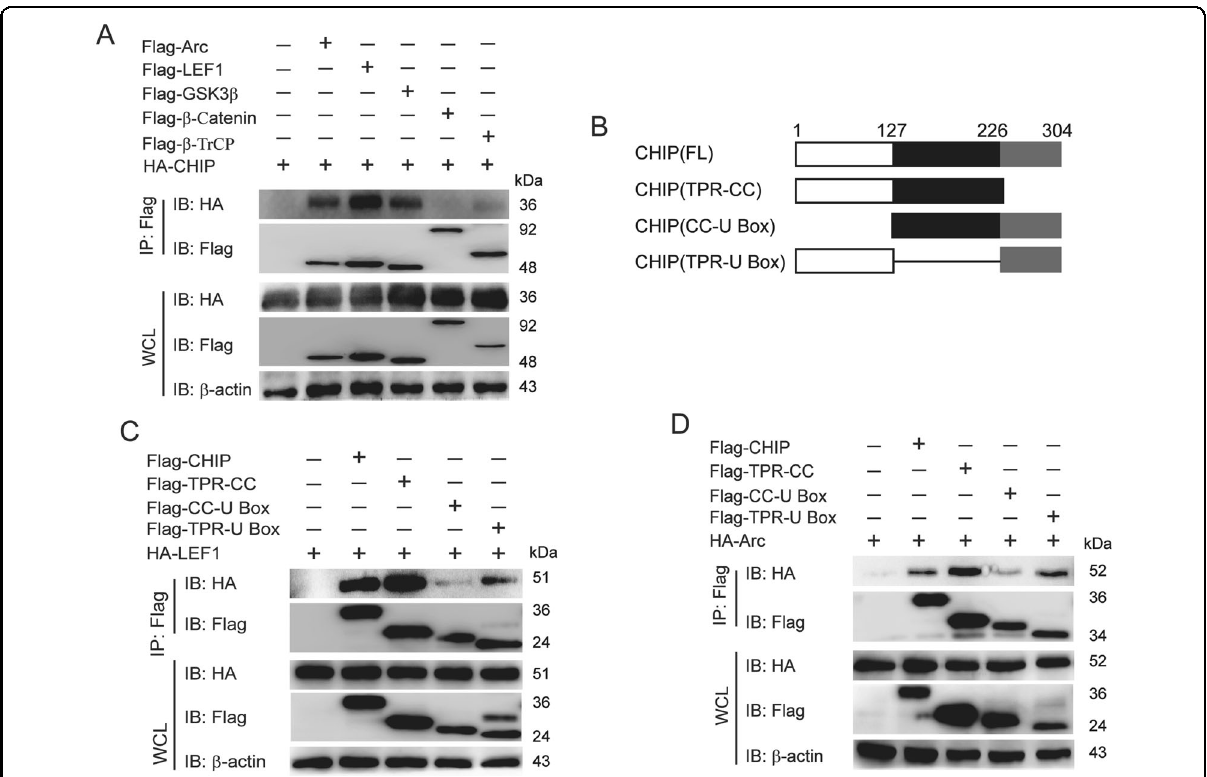
Fig. 3 CHIP interacts with LEF1 and Arc. A HEK293T cells were transfected with HA-CHIP and Flag-Arc, Flag-LEF1, Flag-GSK3 β , Flag- β -catenin, or Flag- β -TrCP, and the cell lysates were detected by co-immunoprecipitation and immunoblotting. B The domain structure of CHIP. Numbers indicated the amino acid position in construct. C – D HEK293T cells were transfected with HA-LEF1 ( C ) or HA-Arc ( D ) and Flag-CHIP or Flag-CHIP domains. Then the protein interactions were detected by co-immunoprecipitation and immunoblotting as fi gures shown. All results were representative of three independent